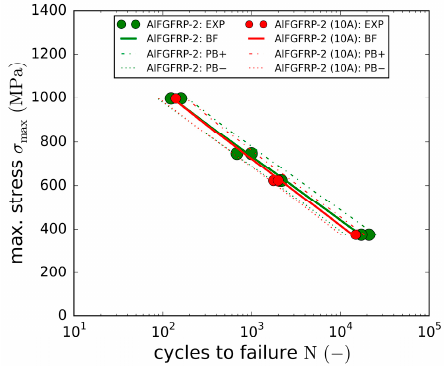
Figure 25. SN curves of AlFGFRP-2 with regression curves and prediction bands: sole mechanical fatigue loads (green) and combined electro-mechanical loading with a constant current of 10 A (red).